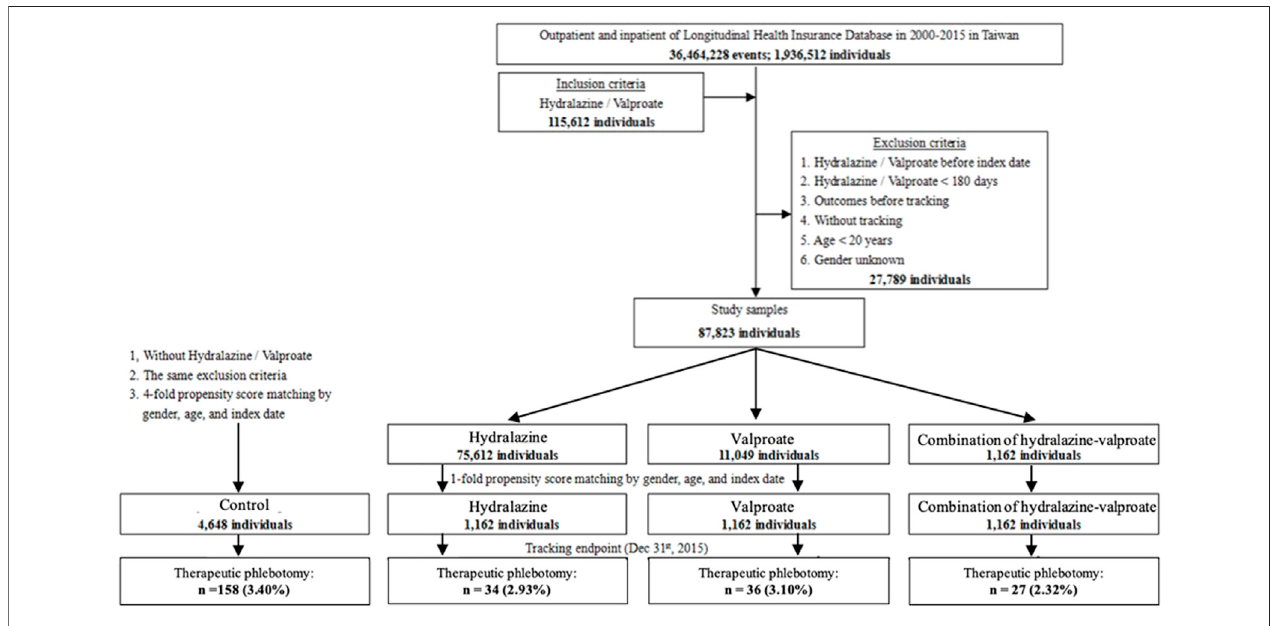
FIGURE 1 | Flowchart of patient